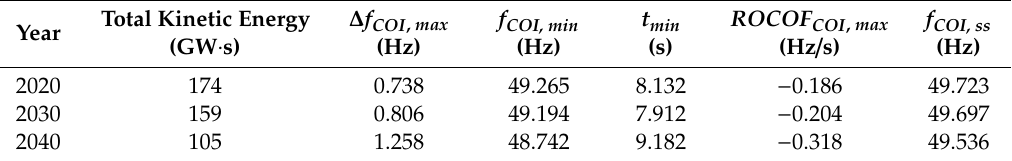
Table 8. Summary of frequency response indicators for Scenario 0: the year 2020, 2030, and 2040.